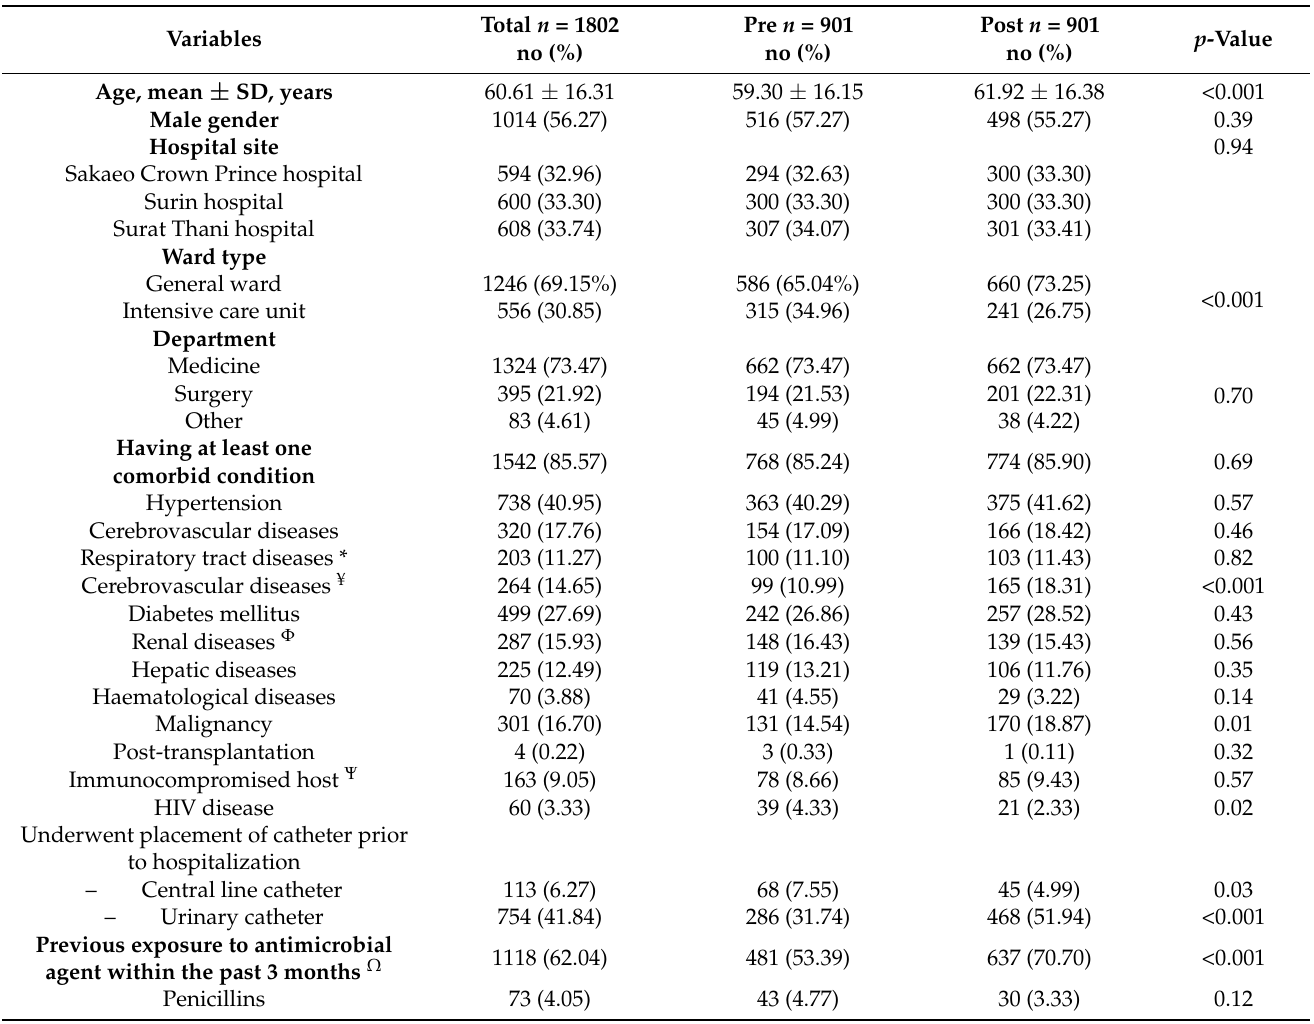
Table 1. Characteristics of patients in the pre- and post-implementation